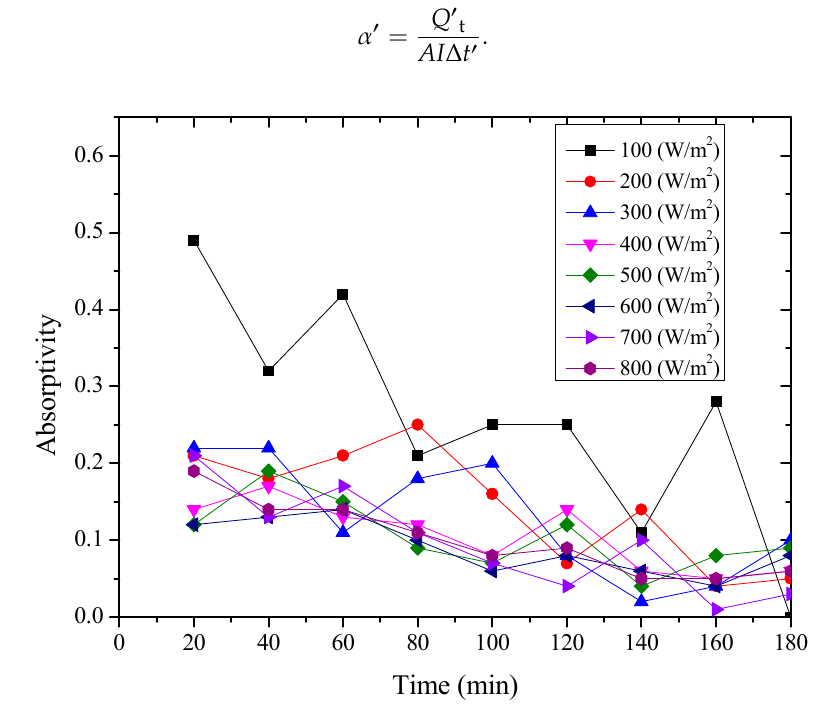
Figure 8. Variation of the instantaneous absorptivity for the polished aluminum sheet.